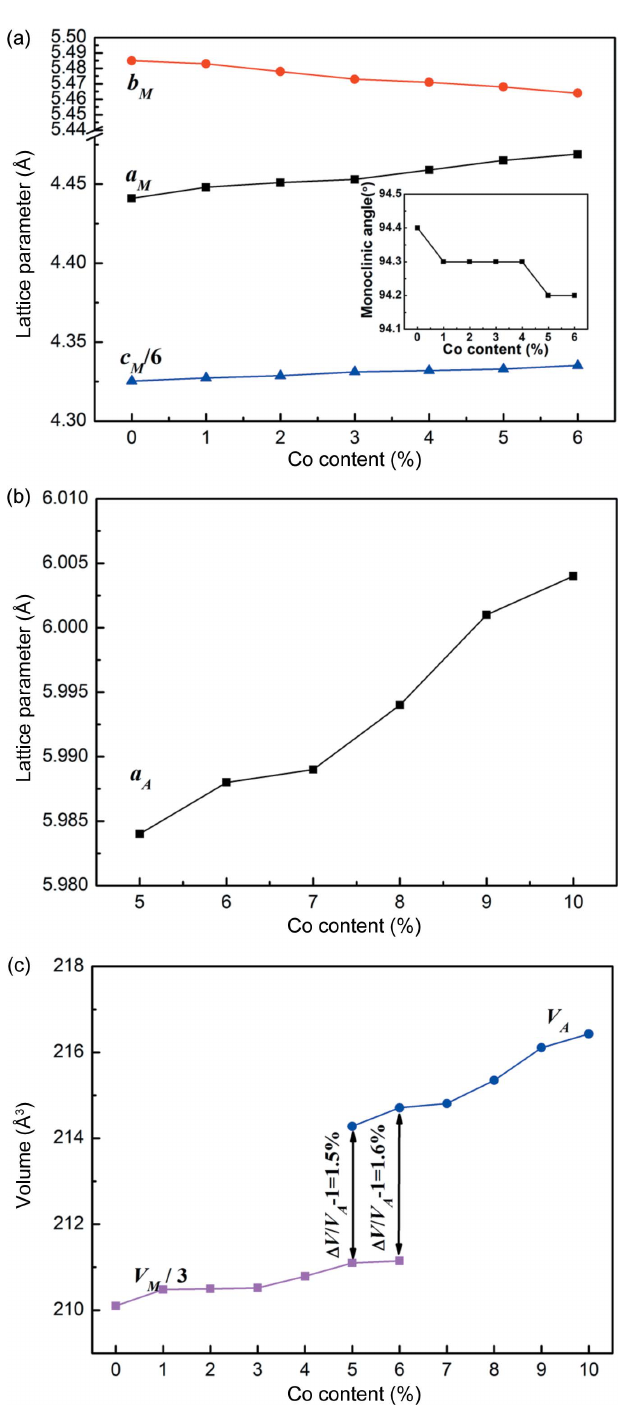
Figure 2 ( a ) The compositional dependence of the lattice parameters for 6 M martensite for the ribbons with x = 0–6. ( b ) The compositional dependence of the lattice parameter for austenite for the ribbons with x = 5–10. ( c ) The compositional dependence of the unit-cell volume for austenite and 6 M